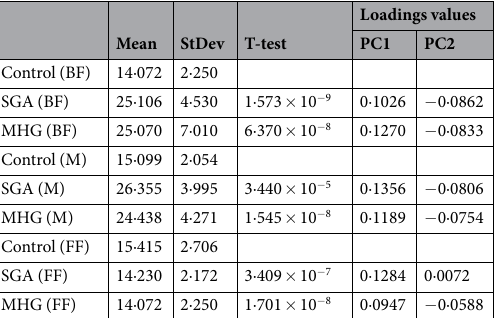
Table 3. Abundance of PC(36:1). Mean and standard deviation of abundance of PC(36:1), p-value associated with the difference between exposed and control samples and the loadings in the PCAs (Fig. 2). PC(36:1) is not a CBM due to the similar abundance across formula fed groups. BF, breastfed; M, mixed feeding; FF, formula-